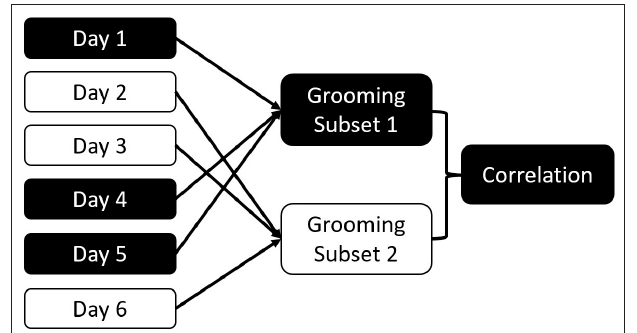
FIGURE 1 | Schema of the consistency measure. Data are randomly divided into two subsets based on the collection day. Dyadic interactions for all dyads are aggregated for each subset. The two subsets are correlated. This process is repeated 100 times to calculate the consistency of the overall dataset for this interaction type.